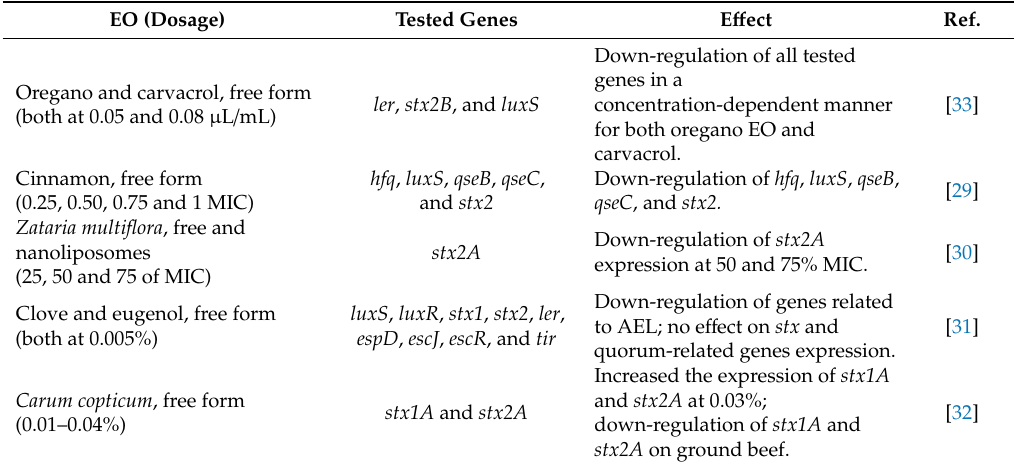
Table 1. Influence of EOs on the expression of genes related to virulence (in vitro) on E. coli. EO (Dosage) Tested Genes E ff ect